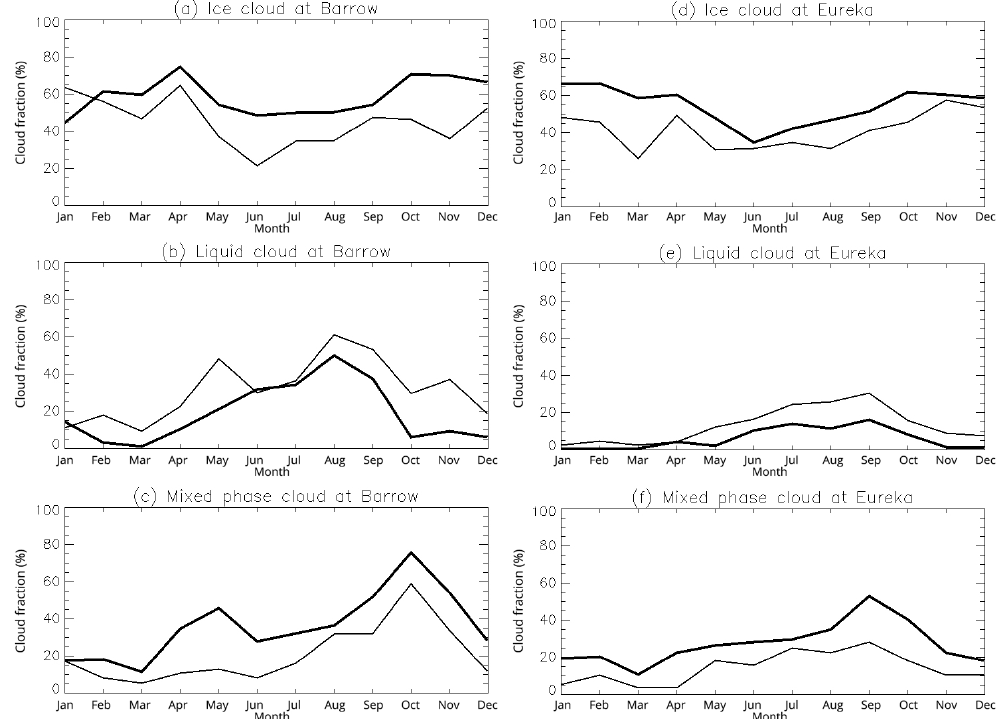
Figure 8. Monthly mean cloud fraction from surface observations (thick line) and 2B-CLDCLASS-lidar (thin line) 2006–2010 (a) ice clouds, (b) liquid clouds, and (c) mixed-phase clouds at Barrow, plus (d) ice clouds, (e) liquid clouds, and (f) mixed-phase clouds at